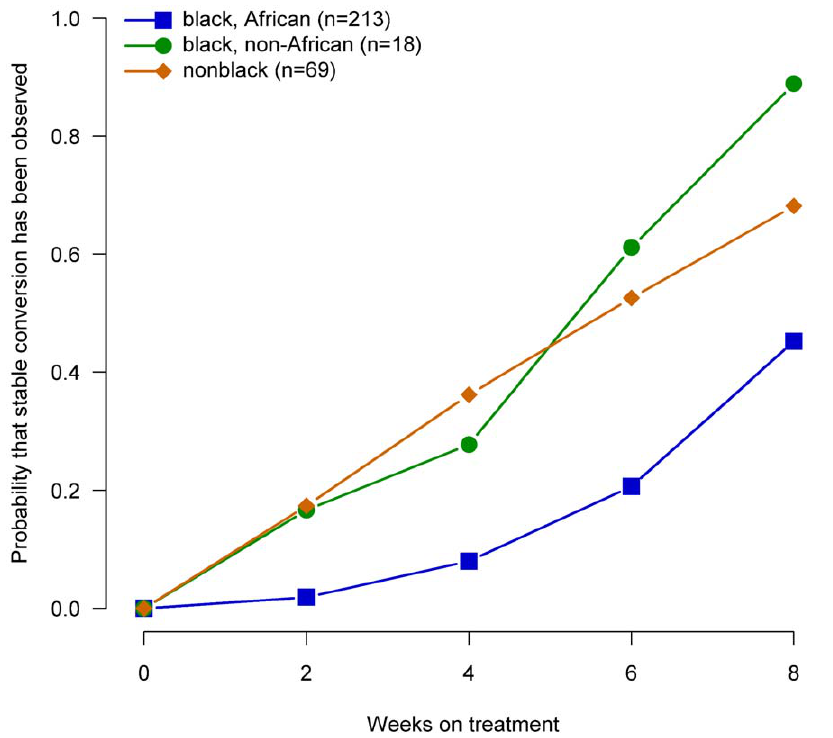
Figure 7. Probability of sputum culture conversion in liquid media by race (black and non-black), African/non-African site and week of treatment, TBTC Study 28 protocol-correct patients.